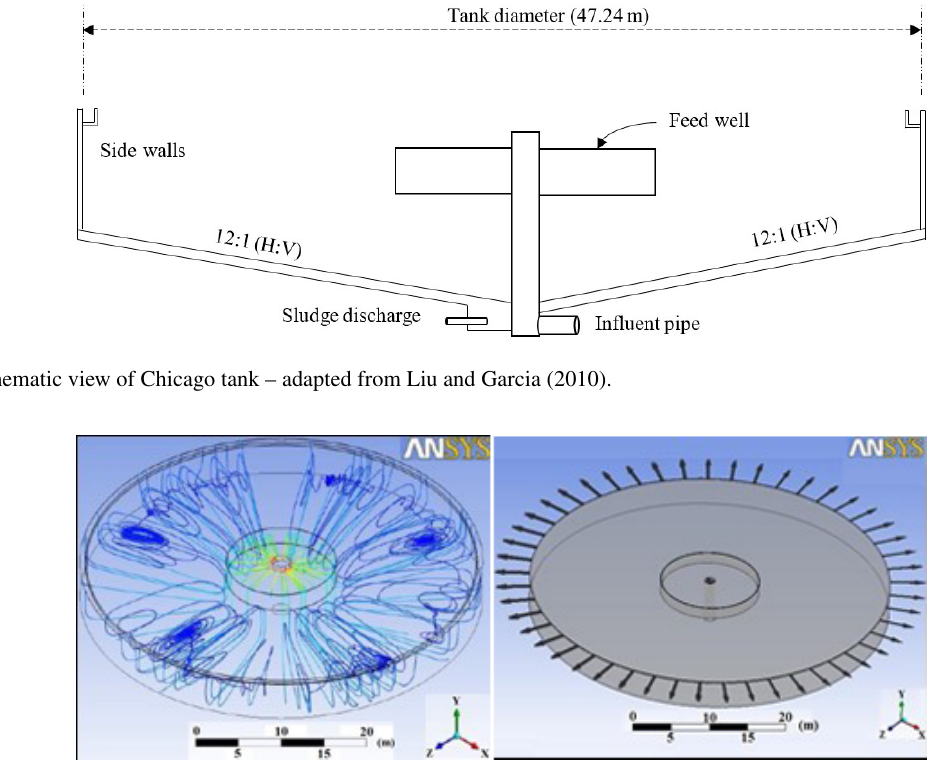
Figure 2. Flow lines and directions in the settling